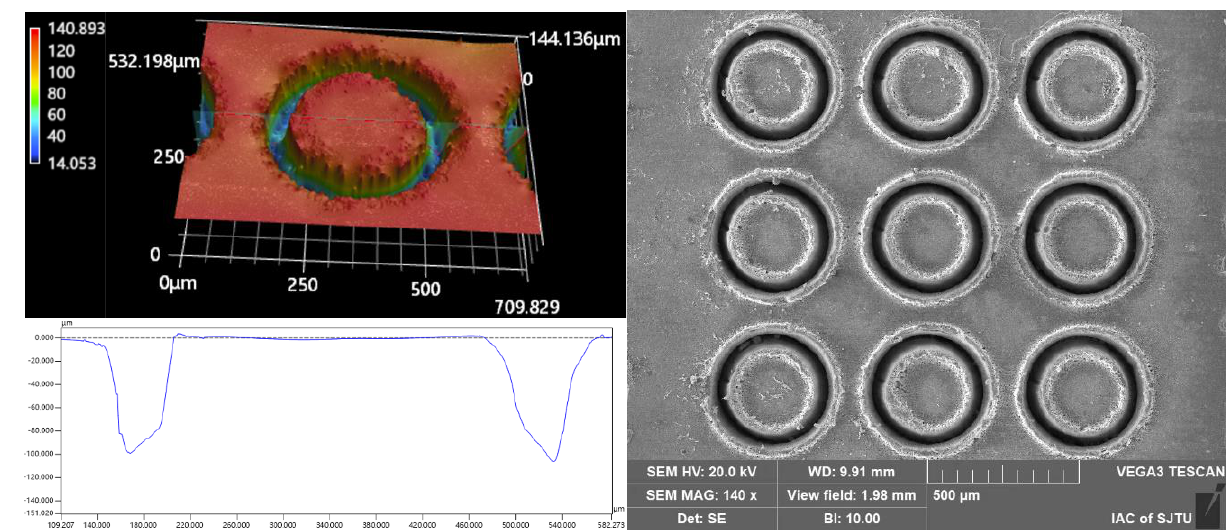
Figure 13. The cross-section profile and SEM image of the micropillars fabricated with a laser translation velocity of 0.2 m/s at a pulse energy of 50 μJ and a pulsed repetition rate of 600 kHz.